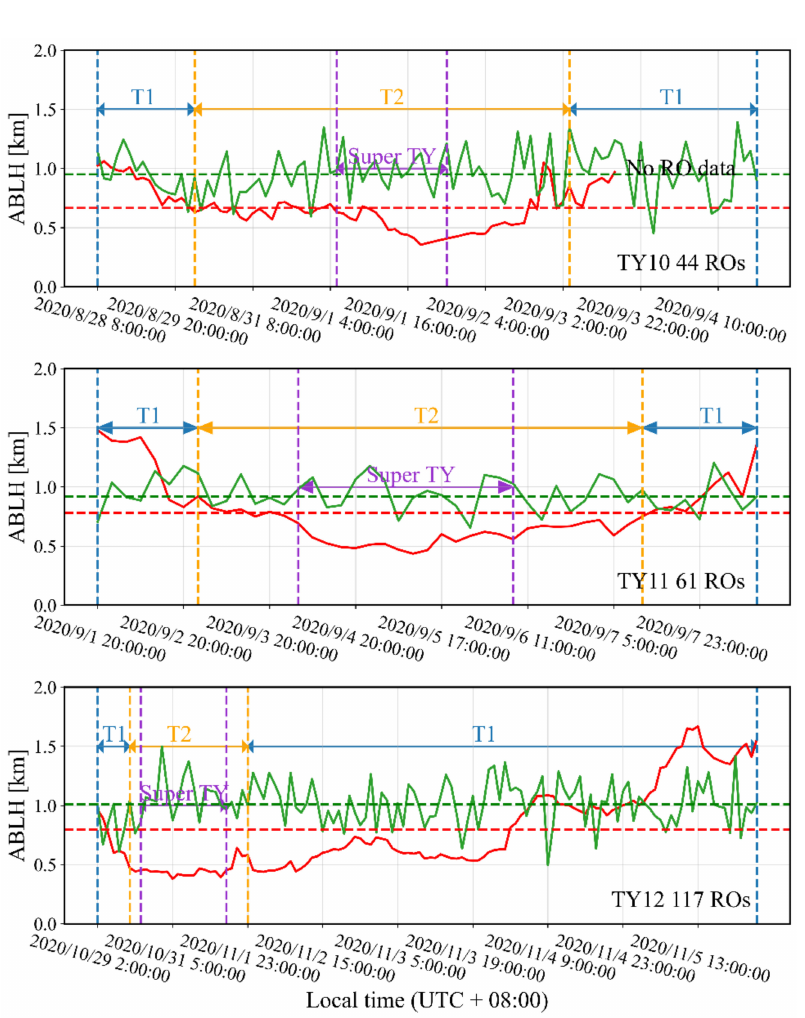
Figure 8. Variation in the ABLH along each typhoon’s (TY10–TY12) track, resulting from the co- located COSMIC-2 profiles (based on a 600 km spatial window and a 12 h time window, red curve) and the results from ABLH climatology (green curve). The legend of Figure 8 is the same as the legend of Figure